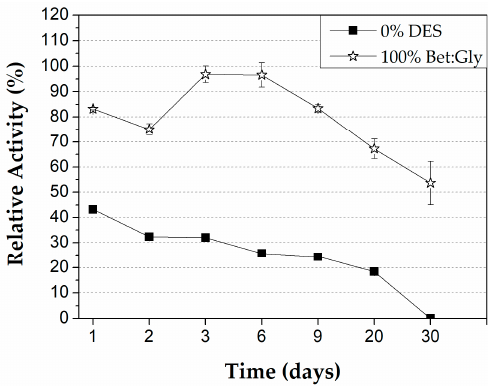
Figure 9. Thermal stability of immobilized CALB in PLA microreactor, at 60 °C, after incubation in 100% DES Bet:Gly and 100% buffer. Reaction conditions: 0.25 mM pNPB in 50 mM phosphate buffer pH 7.5, 40 °C, flow rate 300 μ L/min ( t R = 30 sec).